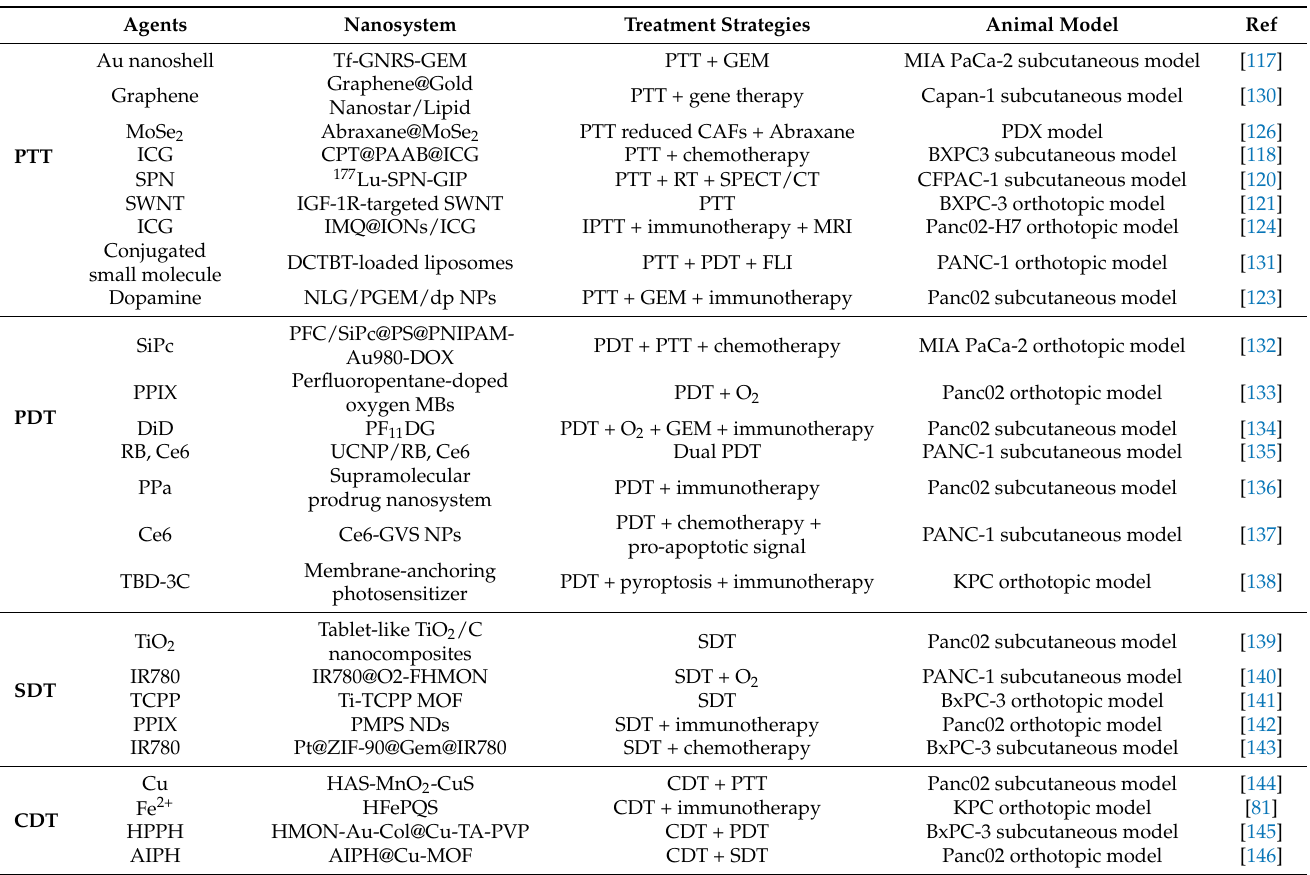
Table 5. Summary of recent advances in well-designed nanosystem-mediated PTT, PDT, SDT, and CDT for the treatment of